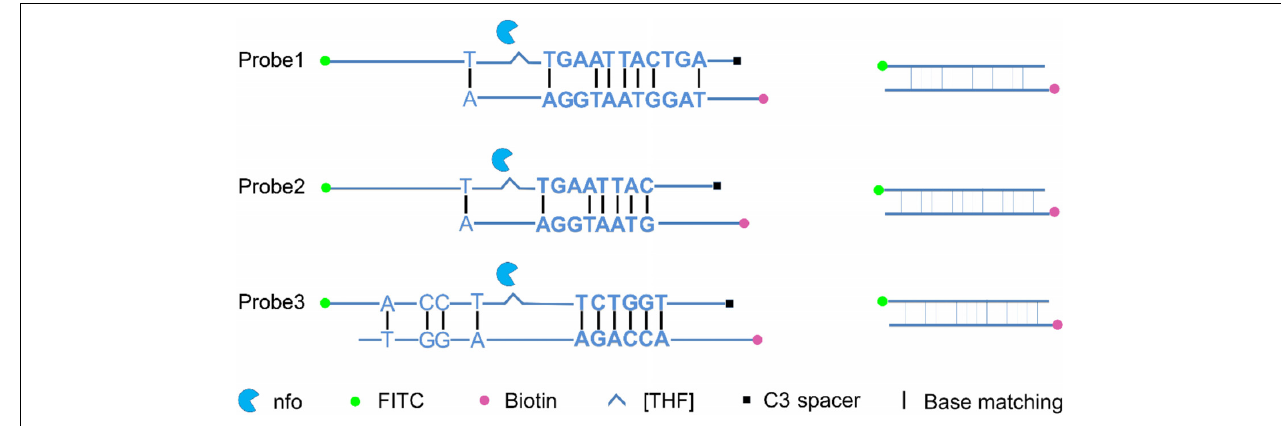
FIGURE 6 | Analysis of the dimer structure between the probe and reverse primer. The reverse primer could form a five-consecutive base matches with Probe1 or Probe2, and a six-consecutive base matches with probe3. Labels and modifications on DNA, nfo, base matching as well as mismatching are indicated with different shapes and colors, with the legends given at the bottom of the